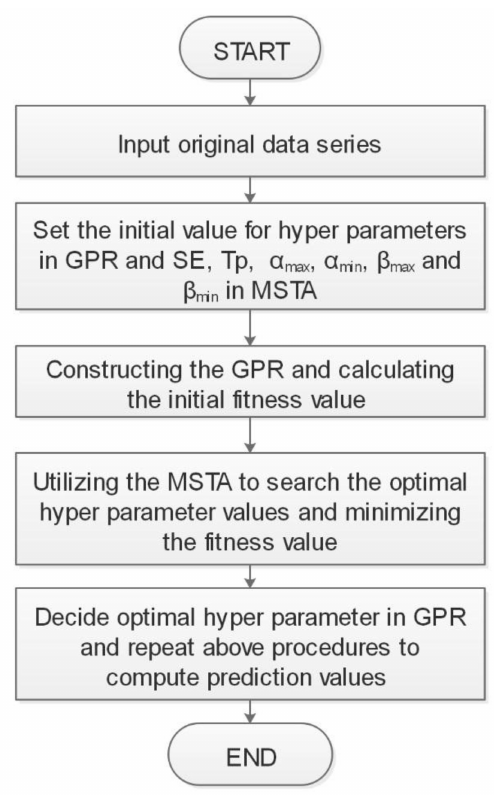
Figure 2. The implementation steps of the proposed modified state transition algorithm-Gaussian processes regression model